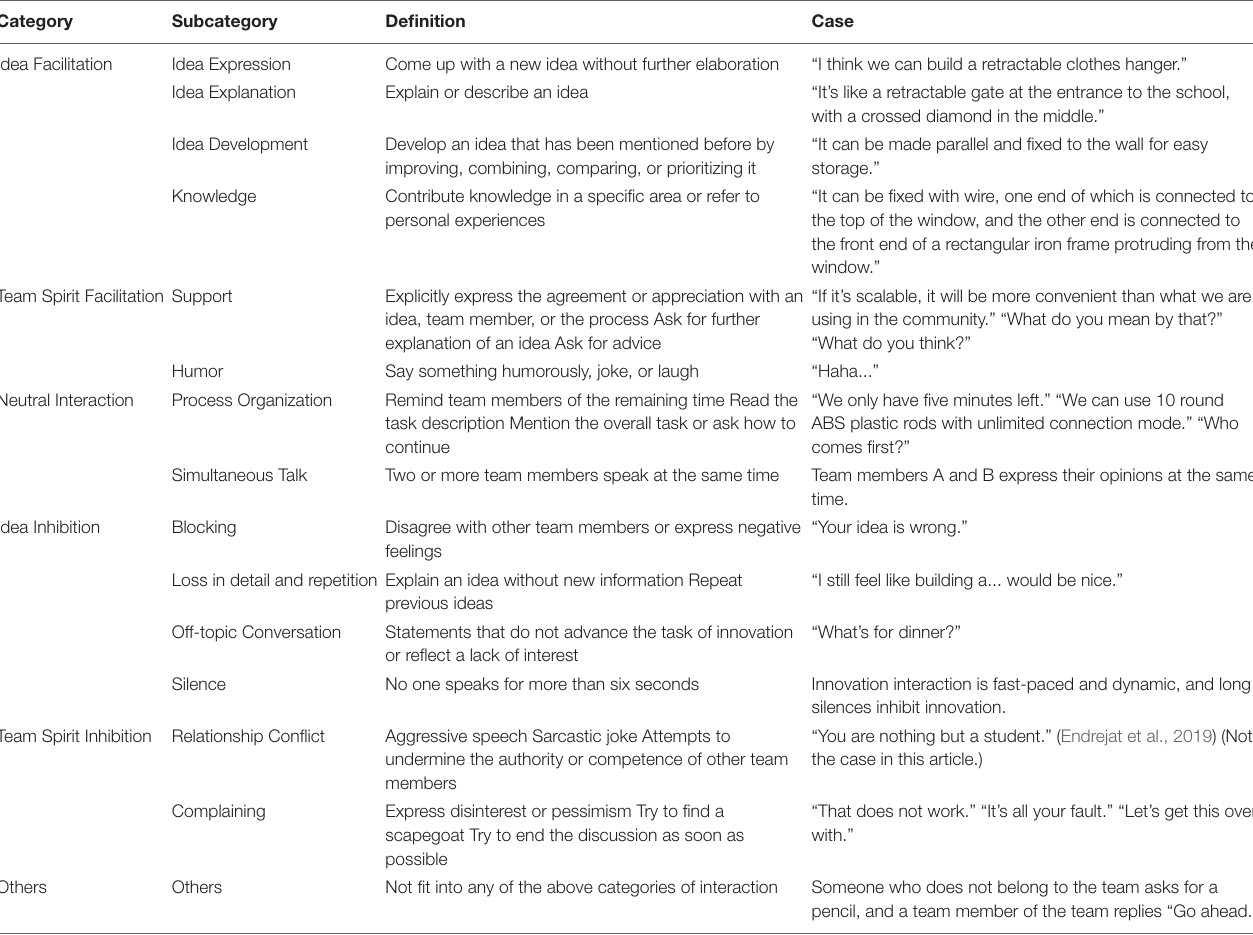
TABLE 1 | AIFI coding scheme and